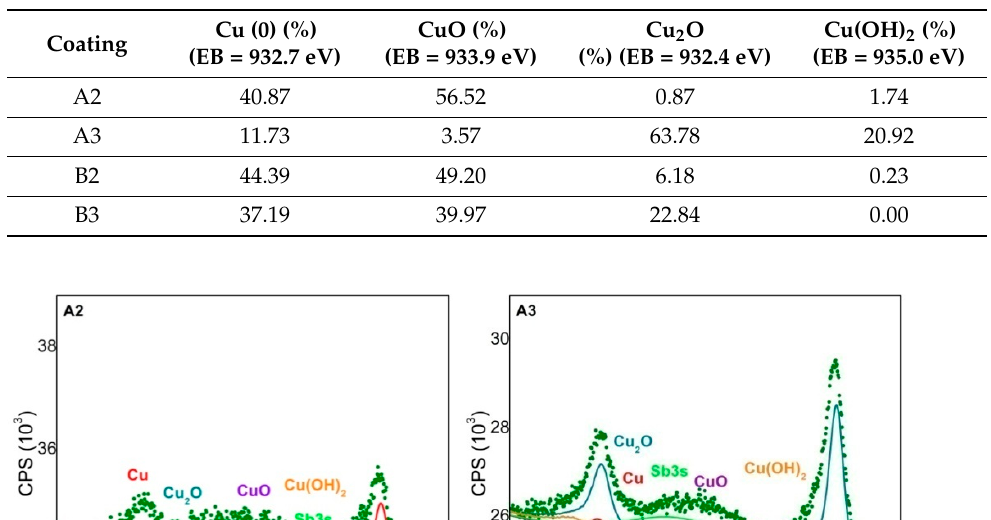
Table 3. Percentage share of various forms of copper in irradiated coatings.